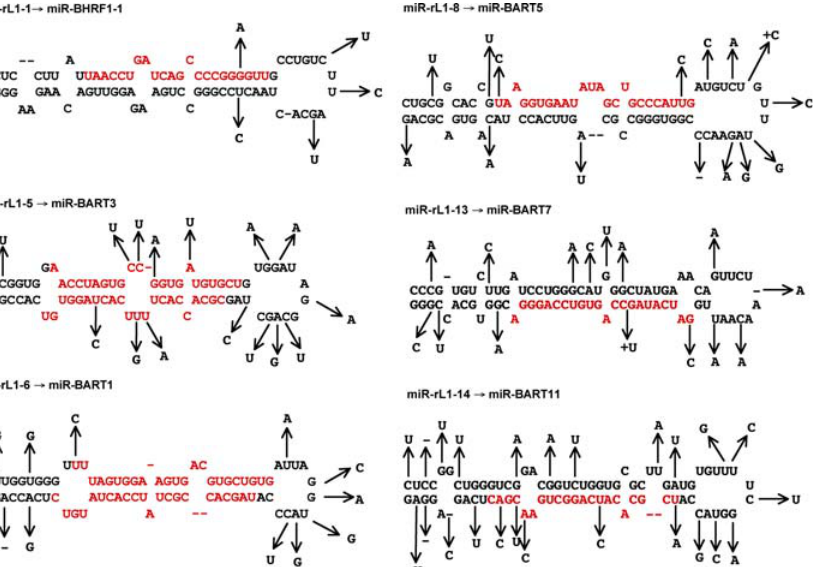
Figure 6. Sequence Comparison of the Predicted Primary miRNA Stem-Loop Structures of the Indicated rLCV and EBV miRNAs The stem-loop shown is the rLCV sequence, with the changes observed in EBV indicated. The mature miRNA sequences are shown in red. In some cases, the miRNA precursors give rise to two mature miRNAs. A ‘‘ þ ’’ sign indicates an